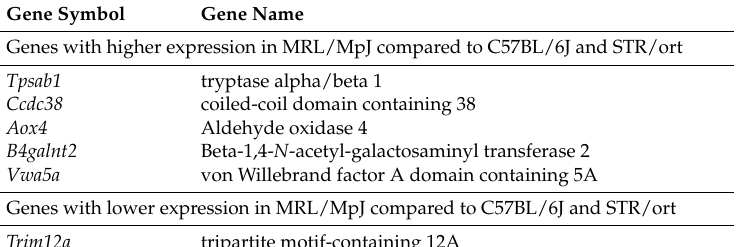
Figure 6. Candidates genes associated with enhanced healing in MRL/MpJ. ( A ) Genes differentially expressed in injured and uninjured MRL/MpJ (MRL) knee joints compared to both STR/ort (STR) and C57BL/6J (BL6) knee joints at all timepoints examined. ( B ) Elevated IHC expression of B4galnt2 in injured and uninjured joints of MRLs. Scalebar = 10 μ m. Table 3 . Genes differentially expressed in MRL/MpJ compared to both C57BL/6J and STR/ort in knee joints and compared to C57BL/6J in digits.